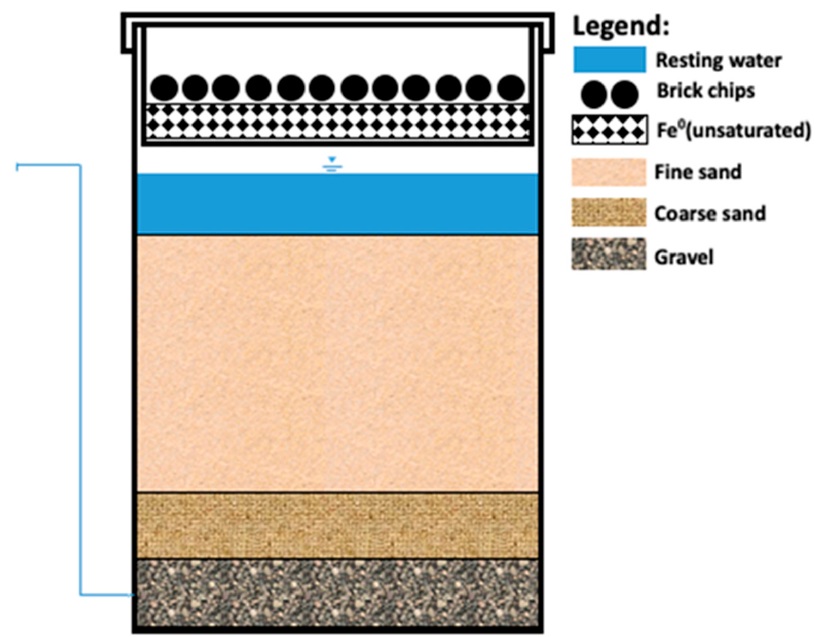
Figure 1. Schematic diagram of a Kanchan arsenic filter (KAF) showing its components (adapted from